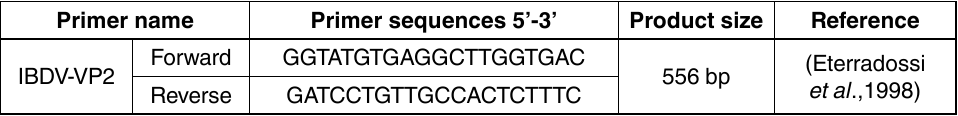
table 1. Sequences of primers used for RT-PCR targeting VP2 gene